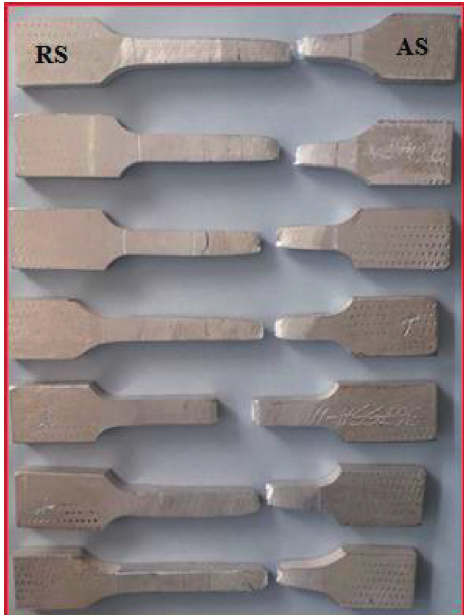
Figure 9: Fractography of tensile test specimen.